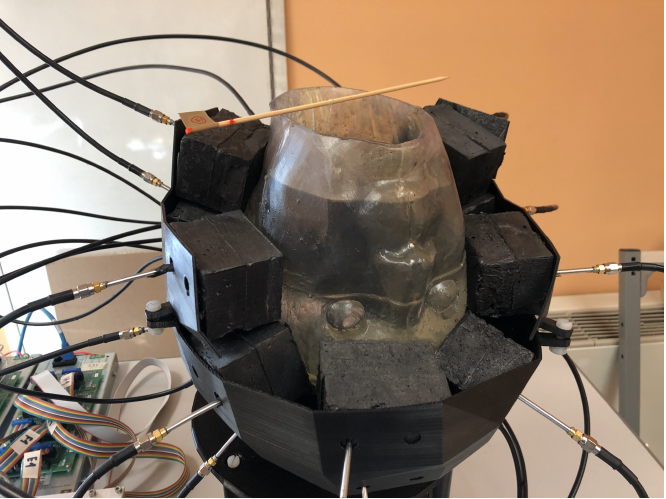
Figure 2. Brick antenna array conformal to the head